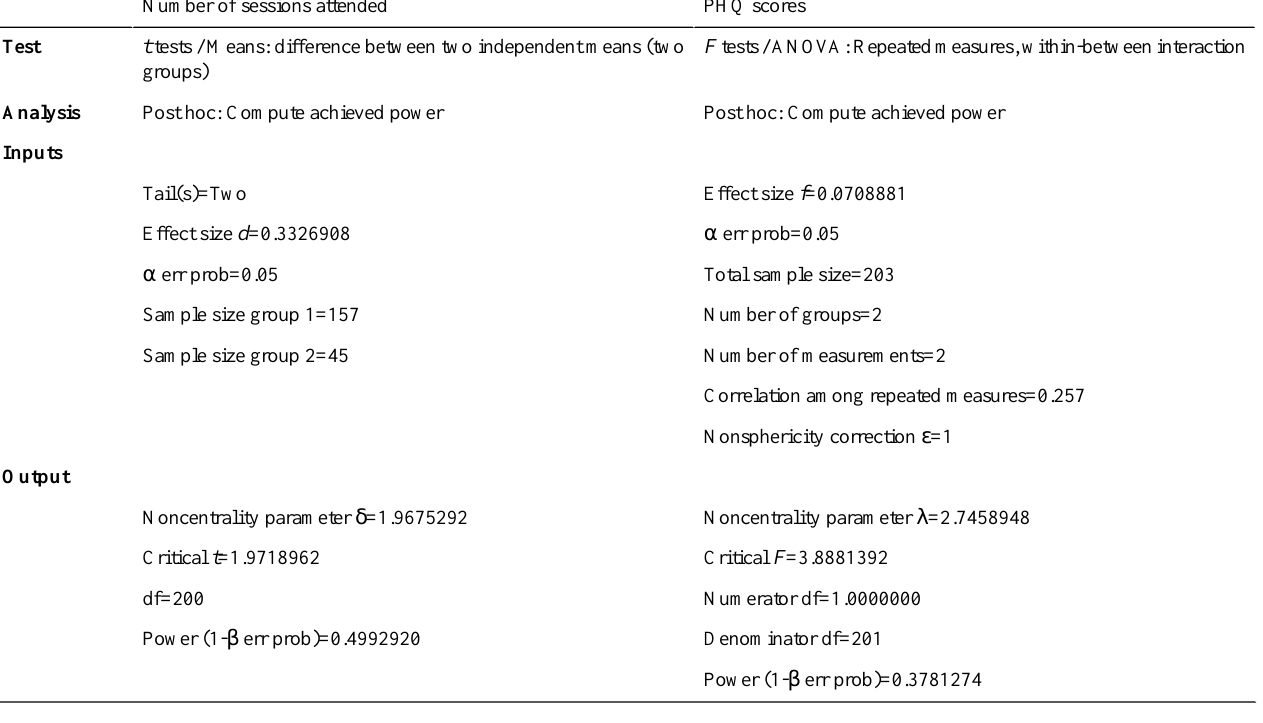
PHQ scoresNumber of sessions attended